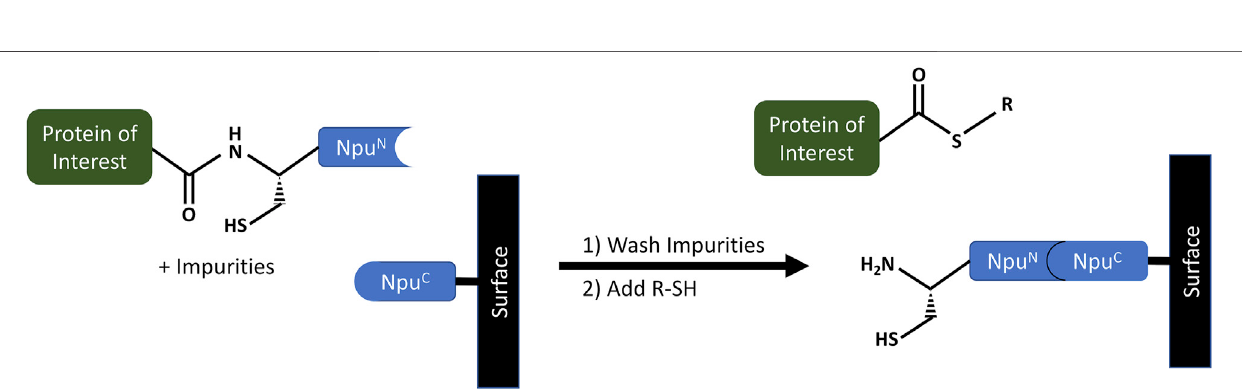
FIGURE 7 | Puri fi cation of recombinant protein alpha-thioester using the Npu C -AA af fi nity resin developed by a team at Princeton University (Muir et al., 2020b; PatentApplicationNo.:US10,526,401B2;prioritizedin2012, fi ledin2017andgrantedin2020).TheNpu N portionofamodi fi edsplit Npu DnaEinteinisgeneticallyfused to the Protein ofInterest (POI). During the loading stepit spontaneously binds tothe Npu C intein fragment immobilized on the af fi nity resin. Aftera wash stepto purify the POI, a thiolysis reaction is triggered to cleave the POI by use of a thiol buffer. The POI is cleaved and eluted to be later used for fl uorescent labeling via a Cys- containing short